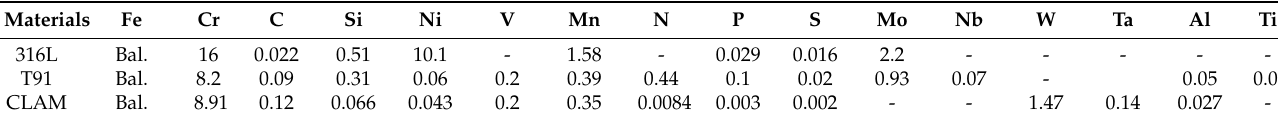
Table 1. Main chemical composition of investigated steel (in